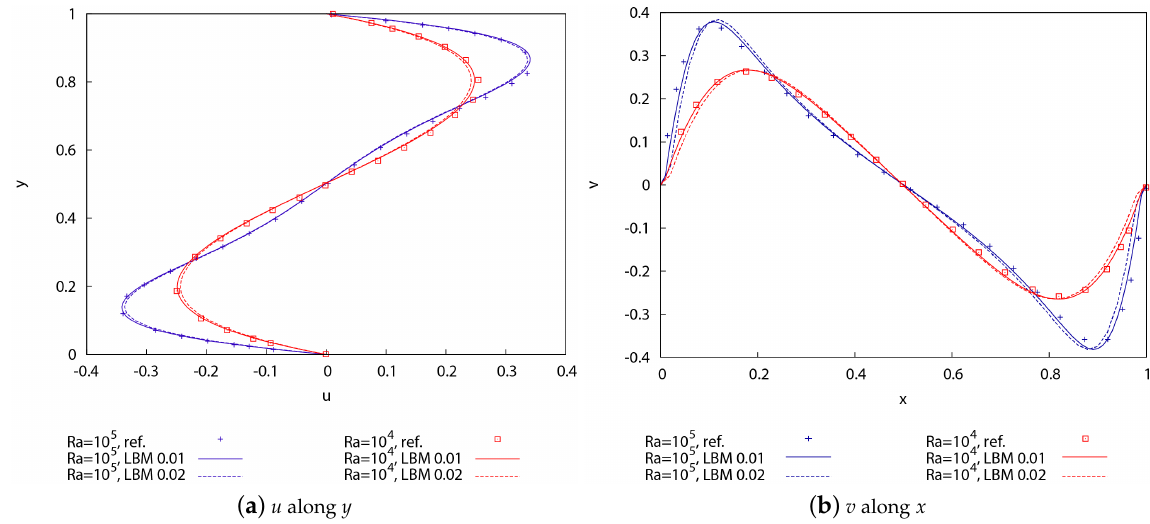
Figure 2. Reference and simulated velocity profiles along the midlines for the double Rayleigh-Bénard